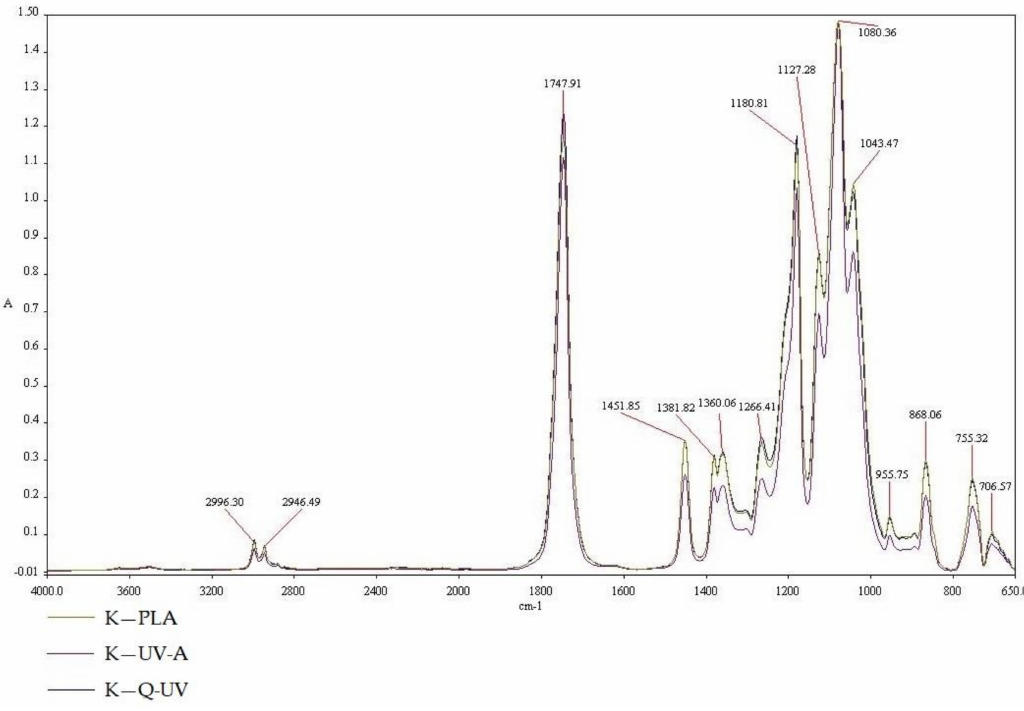
Figure 4. The FT-IR spectra of K—PLA, K—UV-A,